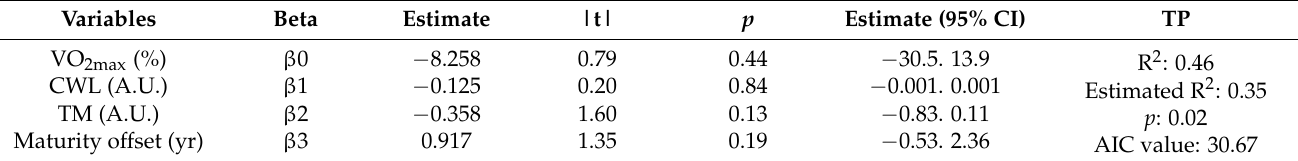
Table 4. Percentage of change in aerobic power with workload and maturity offset using multiple linear regression